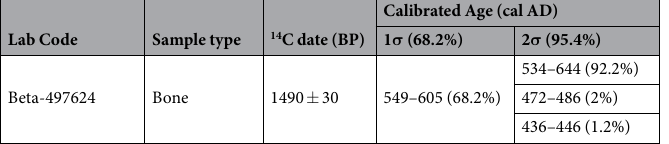
Table 1. Radiocarbon age for the skeleton in this